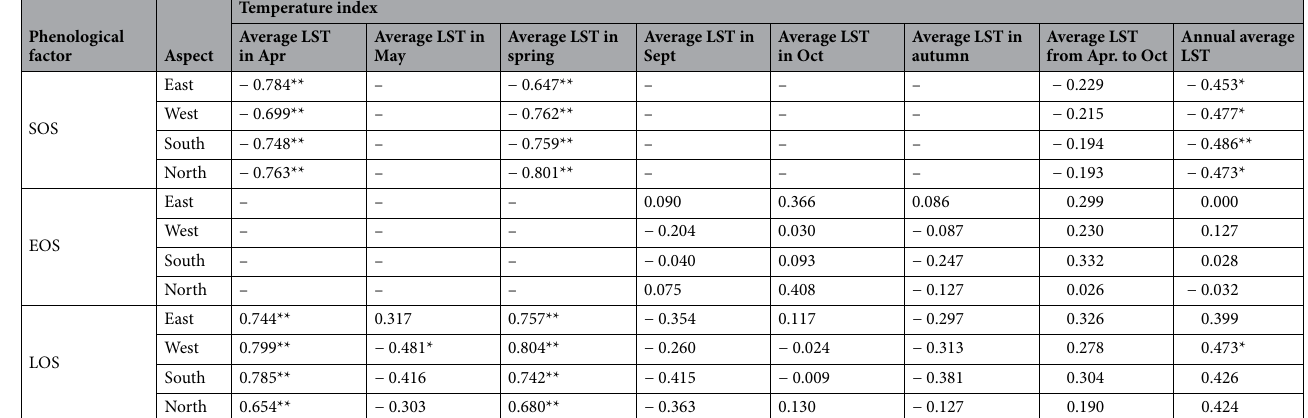
Table 5. Correlation coefficient between RSP and LST in different aspects and time spans. **At level 0.01 (two-tailed), the correlation is significant. *At level 0.05 (double-tailed), the correlation is significant.